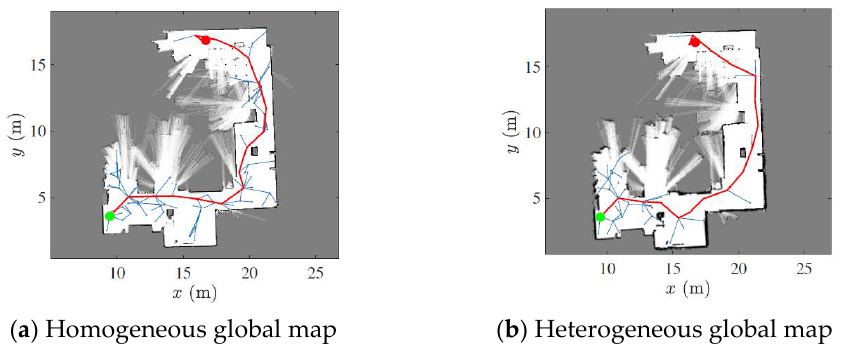
Figure 16. Path planning using the RRT algorithm and different global maps. Starting and end points are shown with red and green points. The robot path is marked with a red line.